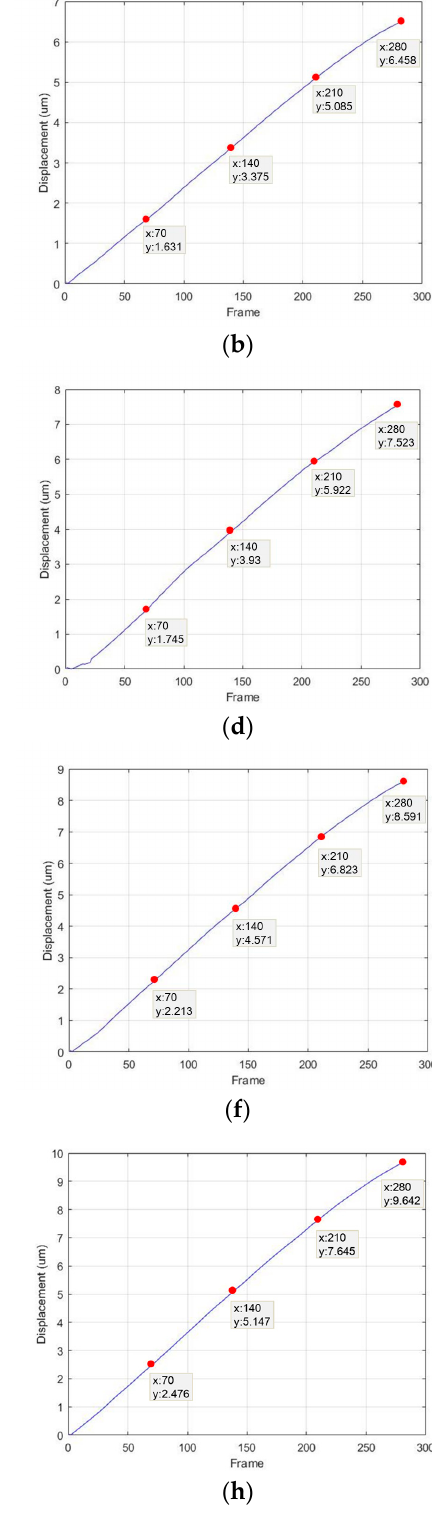
Figure 11. Truncated phase diagrams and displacement diagrams of the 4 pixels. ( a , b ) correspond to pixel A; ( c , d ) correspond to pixel B; ( e , f ) correspond to pixel C; and ( g , h ) correspond to pixel D.